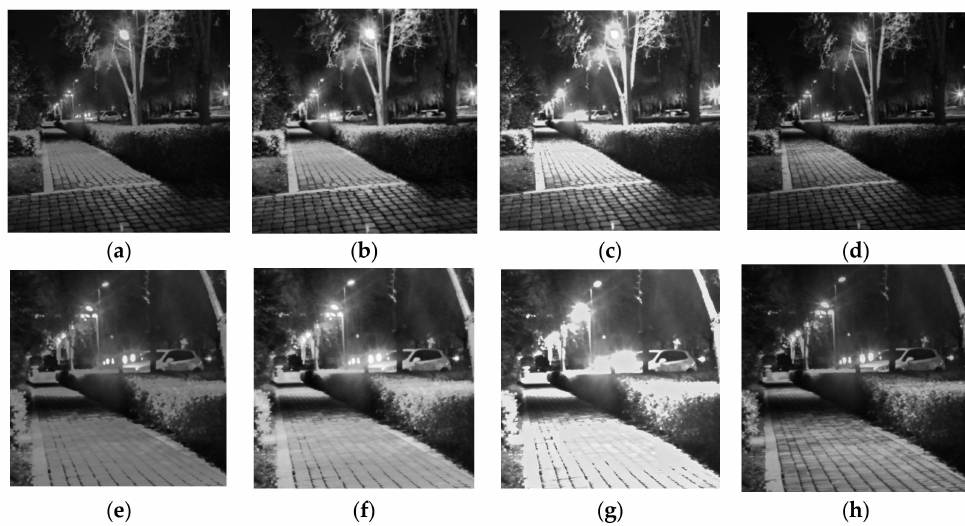
Figure 12. The result of self -comparison. ( a ) The result of condtion1. ( b ) The result of condtion2. ( c ) The result of condtion3. ( d ) Our method. ( e ) The local image of condtion1. ( f ) The local image of condtion2. ( g ) The local image of condtion3. ( h ) The local image of our